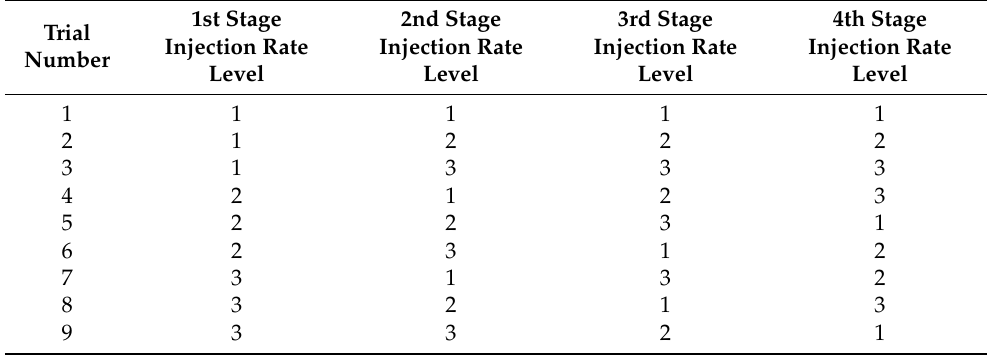
Table 3. L9 orthogonal array.